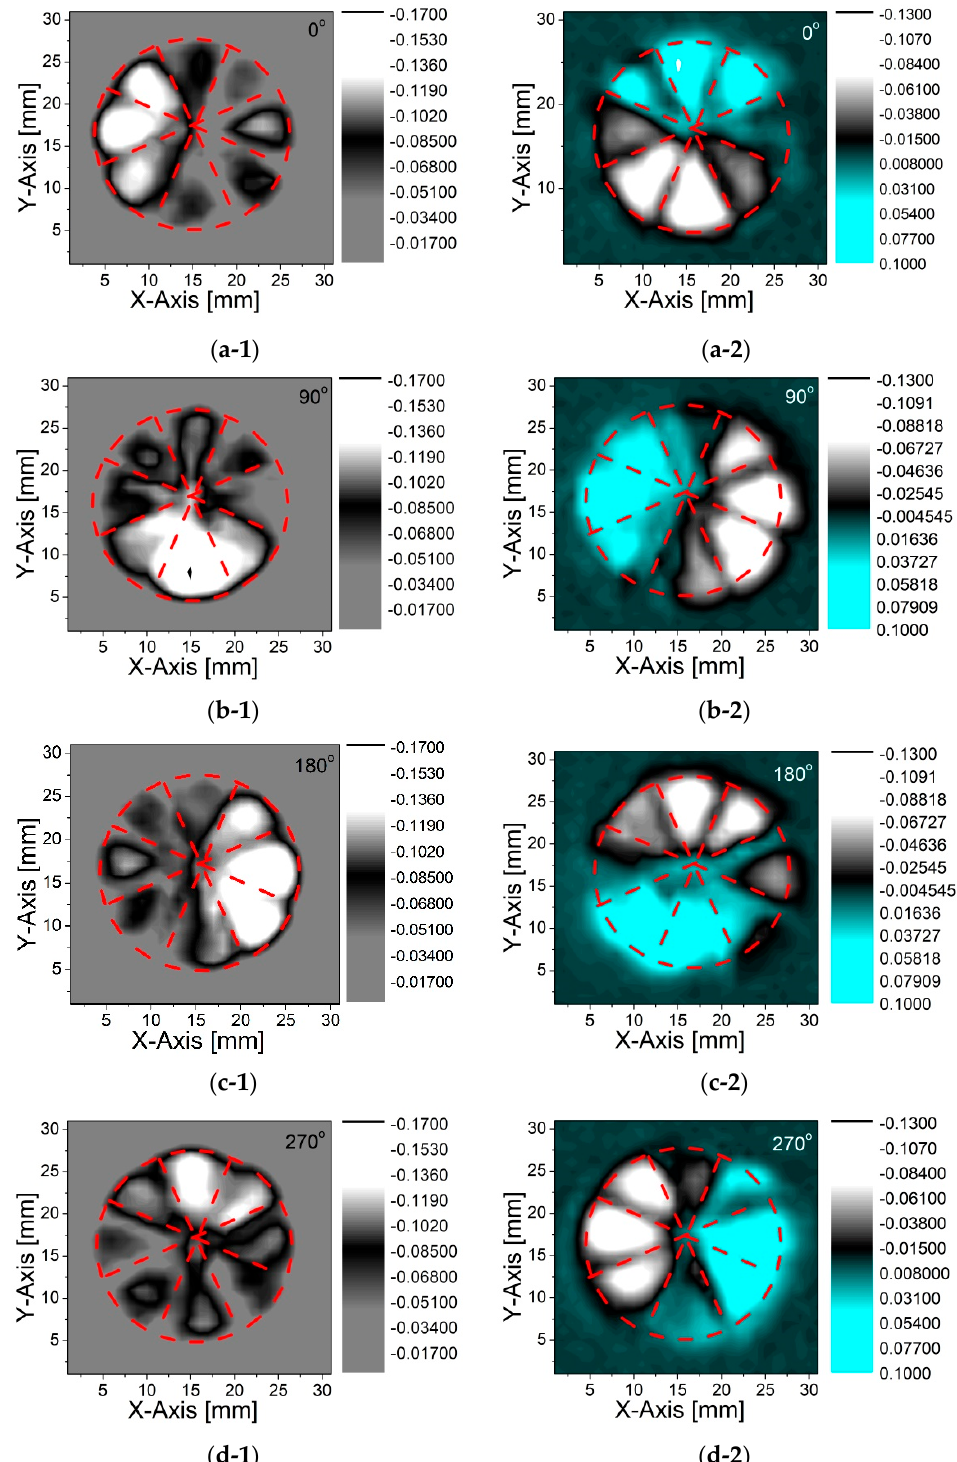
Figure 4. E-Field response of the designed q-plate with respect to the fast axis. The mapped E X components for 0° (azimuthal counter-clockwise), 90° (radial outwards), 180° (azimuthal clockwise), and 270° (radial inwards) orientations of the device are given with the sequence ( a-1 – d-1 ). Similarly, the corresponding mapped E Y components are given in sequence ( a-2 – d-2 ).